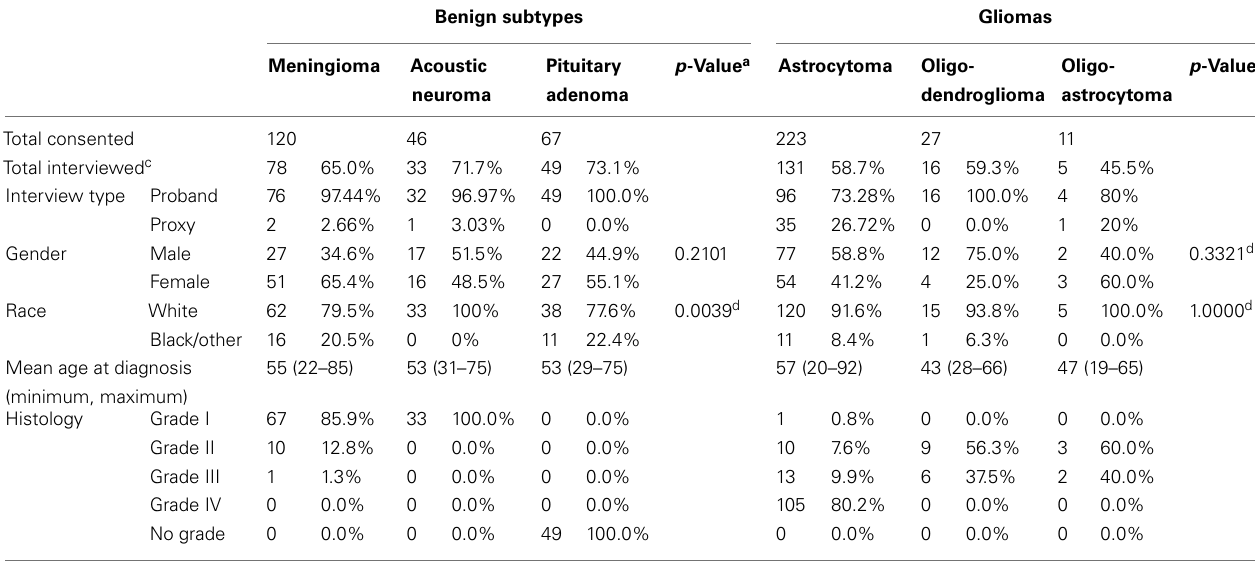
Table 1 | Characteristics of OBTS study